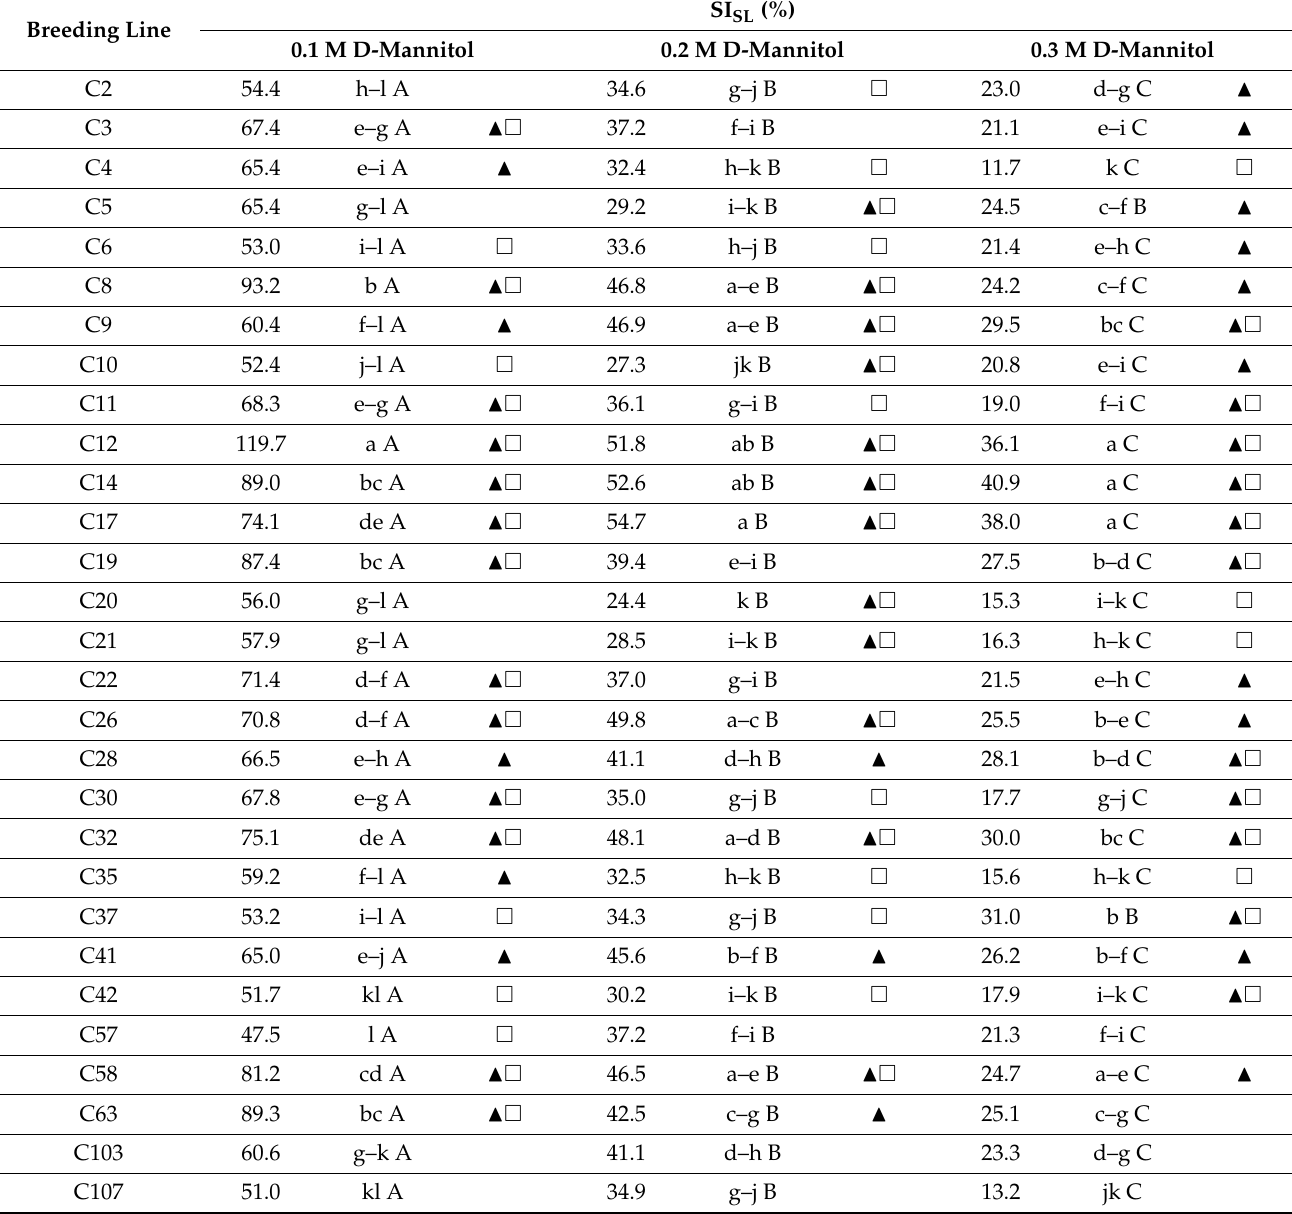
Table 11. Shoot length SI (SI SL ) values of potato genotypes under stress treatment induced by D-mannitol added to the medium at levels of 0.1 M, 0.2 M and 0.3